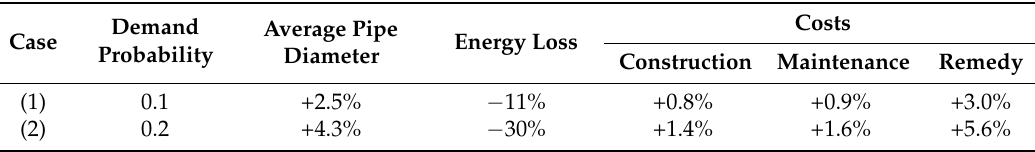
Table 6. Implications of sizing a tree-shaped piping network (with branch demand flow rates